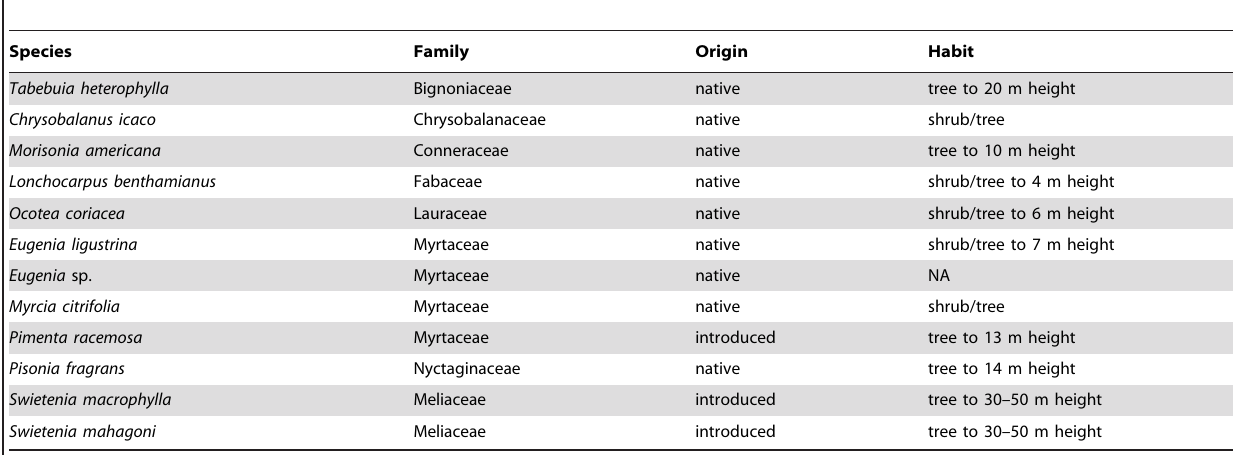
Table 1. List of common woody plant species surveyed for standing levels of leaf damage in March 2008 at Cabrits National Park, Dominica in the Lesser Antilles.